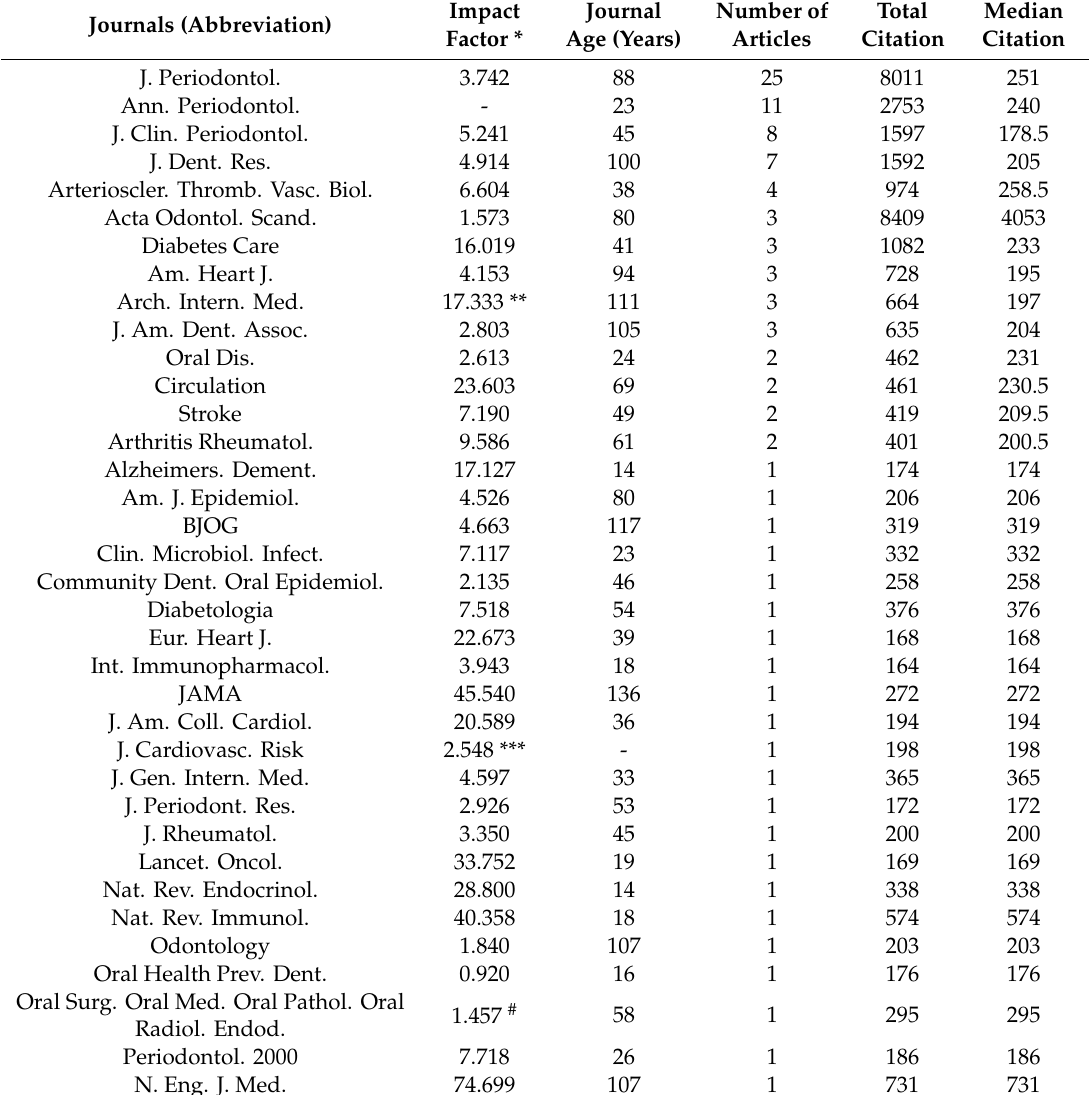
Table 2. List of journals that published the top 100 “classic” articles. Journals